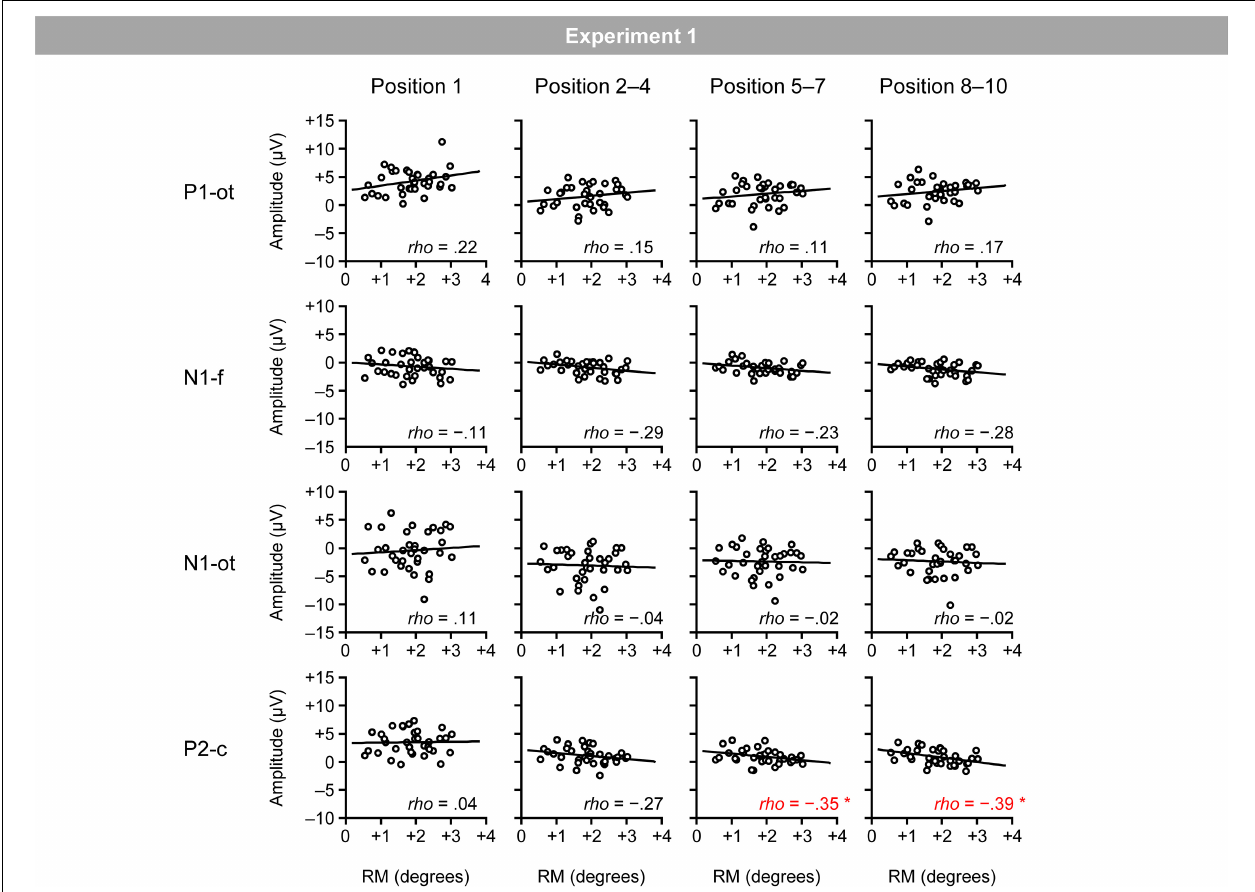
FIGURE 5 | Scatter plots of the relationships between the magnitudes of RM and VEPs. P1-ot: occipito-temporal P1, N1-f: frontal N1, N1-ot: occipito-temporal N1, P2-c: central P2. The linear regression fits to the data are shown. *Indicates p < 0.05 by Spearman’s correlation analysis (two-tailed).